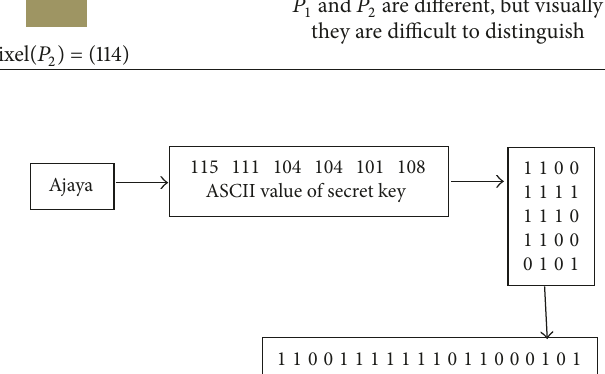
Figure 2: 1D array